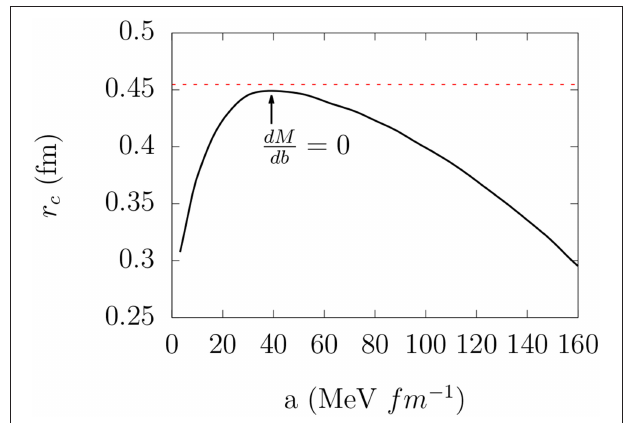
FIGURE 3 | Triplet S hard-core radius r 0 as a function of the confinement parameter a for one channel NN (dashed line) and three channels NN , 11 , and CC (solid line) calculation. In the one channel case the hard-core radius is independent of a . The dependence with a in the three-channel calculation appears through the coupling with de hidden color states. The arrow shows the value of a which minimize the nucleon mass with respect to b .